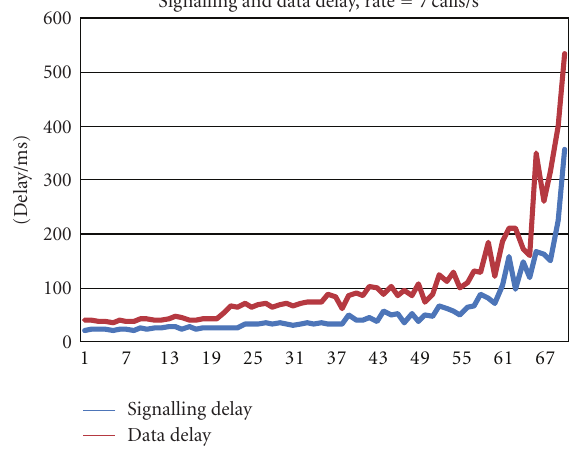
Figure 10: Session delay at 7